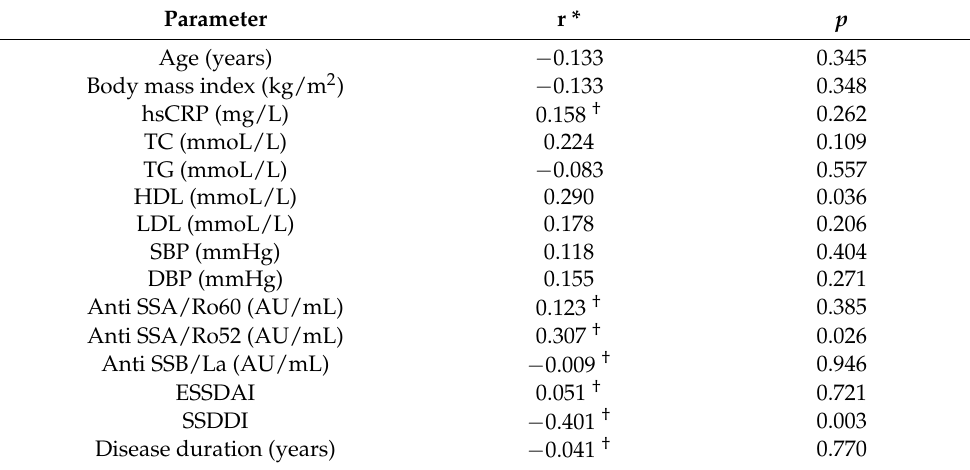
Table 4. Correlation analysis between serum adropin levels and different biochemical and anthropo- metric